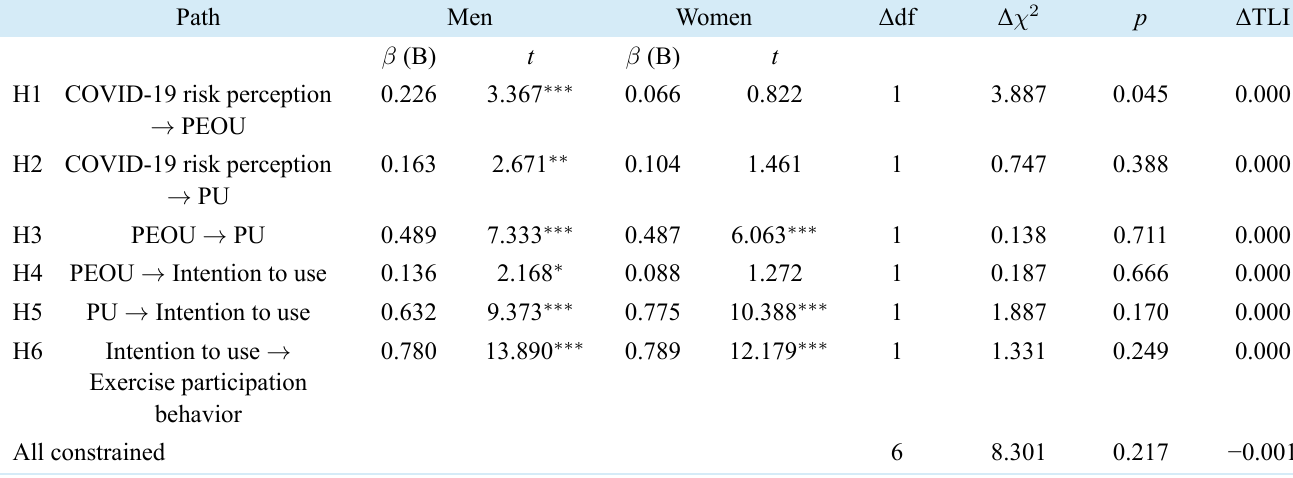
TABLE 6. Comparison of differences between models and parameter estimates of gender with measurement equivalence constraint